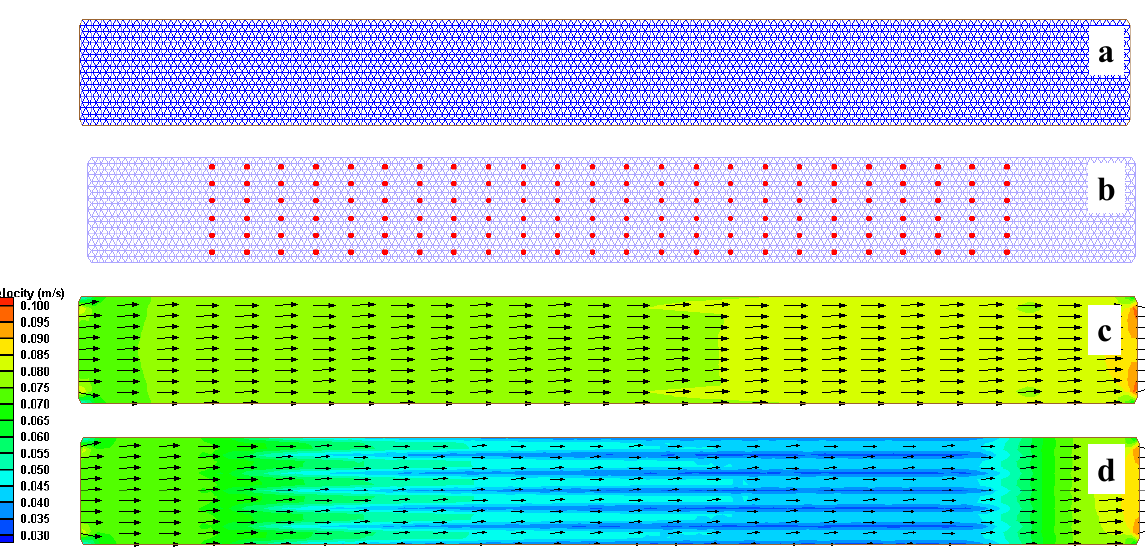
Figure 2. ( a ) Finite Volume Coastal Ocean Model (FVCOM) model grid (in the horizontal plane) for the flume experiment. ( b ) Spatial distribution of cylinders in Run D. ( c ) Surface velocity field in the baseline condition without the cylinder array. ( d ) Surface velocity